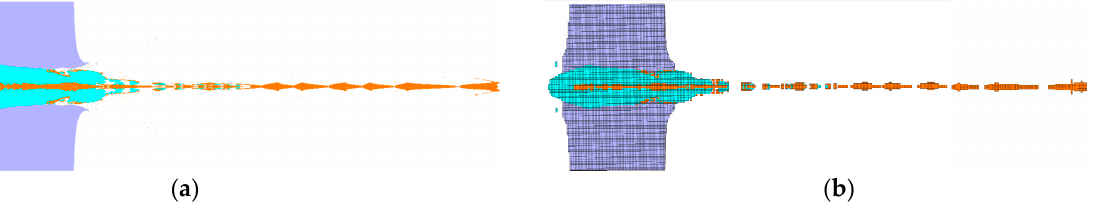
Figure 17. Algorithm transformation and simulation method of the detonation-like reaction effects: ( a ) 2D model at τ ; ( b ) 3D SPH model.